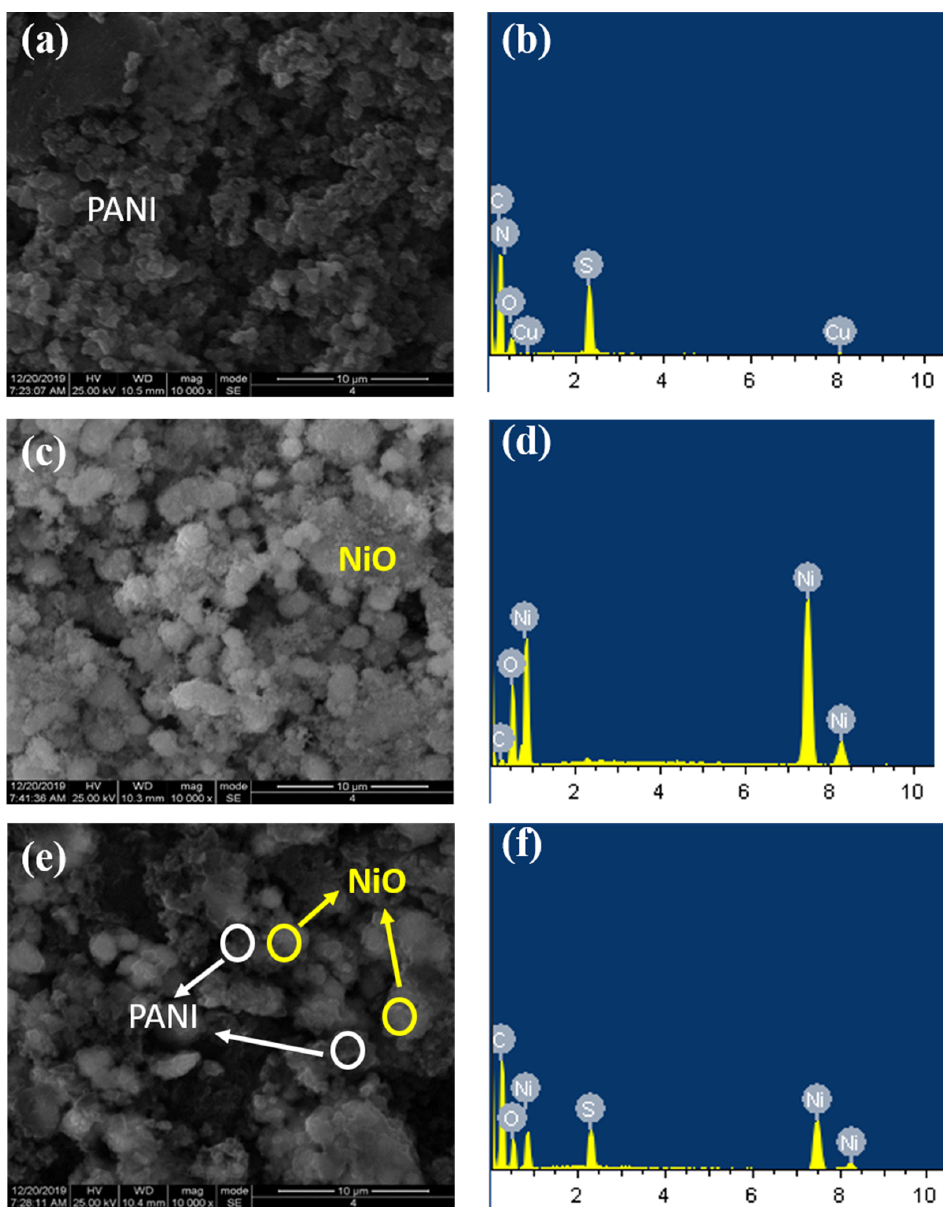
Figure 2. ( a ) SEM image of PANI, ( b ) EDX analysis of PANI, ( c ) SEM image of NiO, ( d ) EDX analysis of NiO, ( e ) SEM image of PANI-NiO-3, and ( f ) EDX analysis of